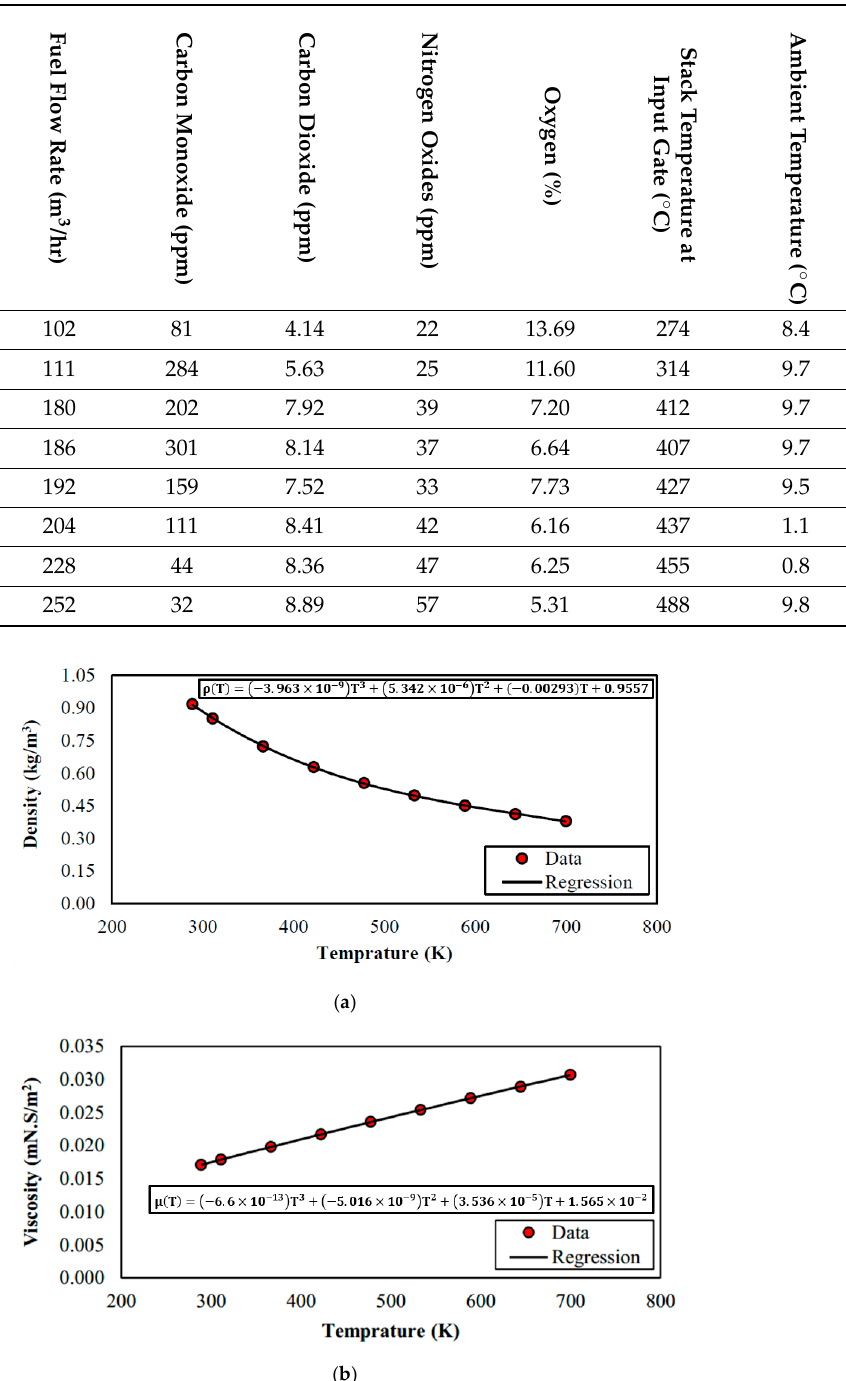
Table 3. Composition of combustion exhaust gases [24].